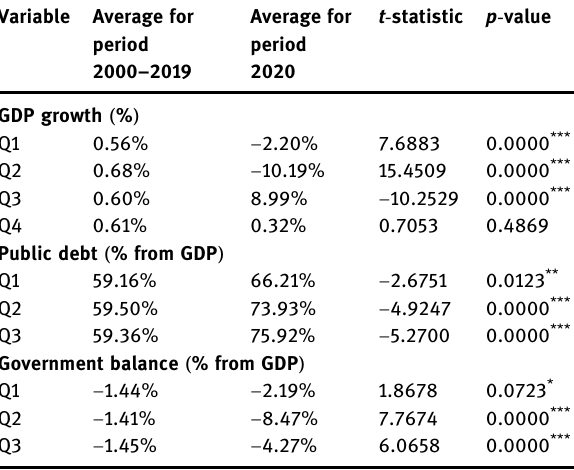
Table 9: Paired sample t - test results for EU 27 countries Variable Average for